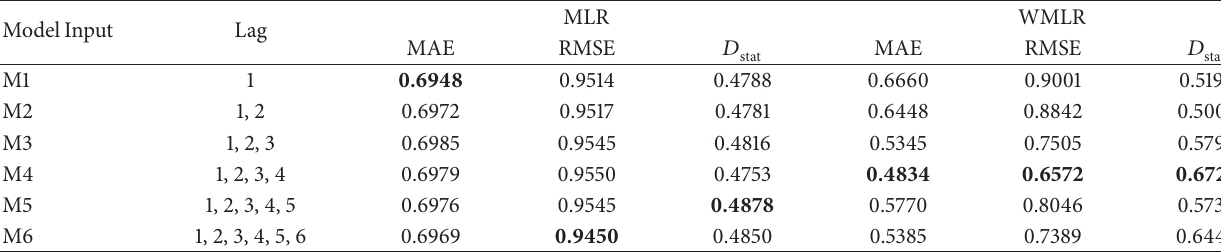
Figure 5: The errors of MLR, WMLR, ARIMA, and GARCH models for crude oil price forecasting. Table 2: Forecasting performance indices of MLR and WLR.